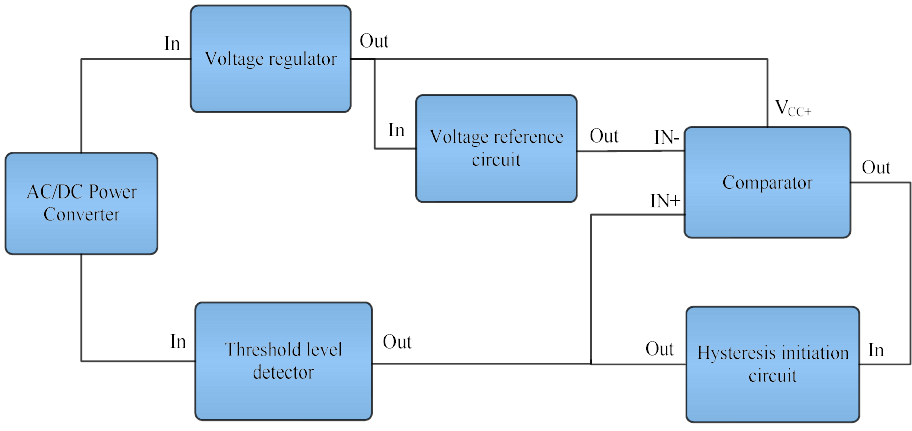
Figure 8. Block diagram of control circuit to drive MOSFETs.